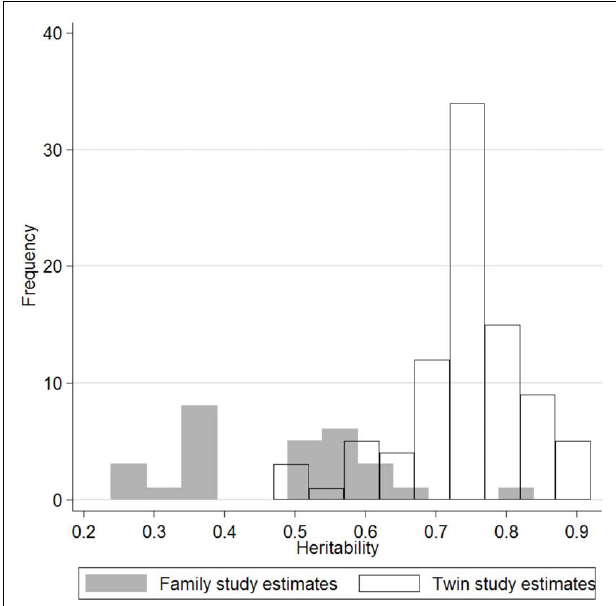
FIGURE 1 | Histogram showing the wide distribution of reported estimates of BMI heritability from twin studies (white bars) and family studies (gray